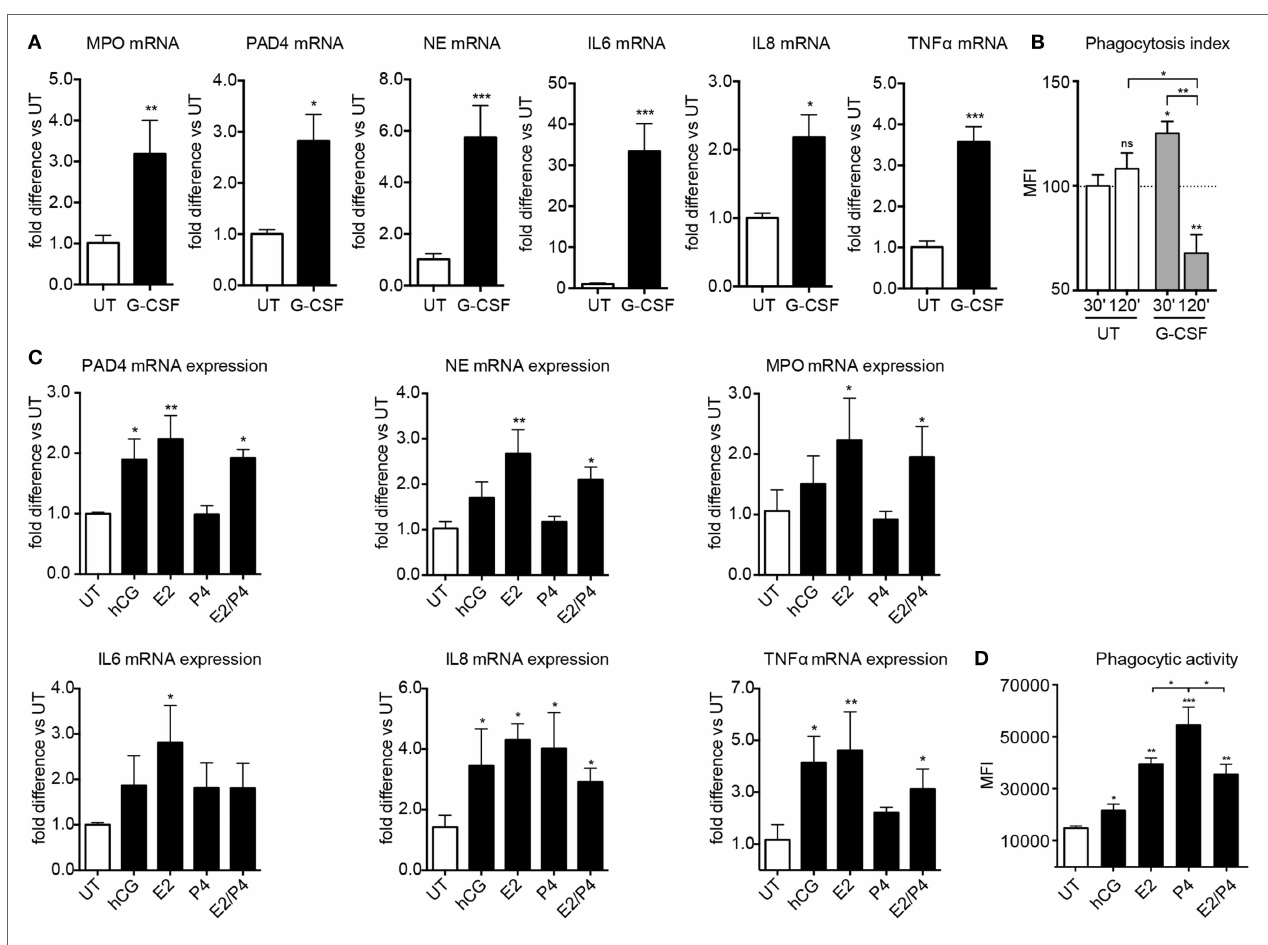
FigUre 5 | sex hormones and g-csF regulate broader aspects of neutrophil effector functions . (a) MPO, PAD4, NE, IL-6, IL-8, and TNF α gene expression analysis by Taqman qRT-PCR in RNA samples obtained from healthy female controls treated in vitro with 12.5 ng/ml rhG-CSF. (B) Phagocytic activity of neutrophils obtained from healthy female controls treated with 12.5 ng/ml rhG-CSF. (c) PAD4, NE, MPO, IL-6, IL-8, and TNF gene expression analysis by Taqman qRT-PCR in RNA samples obtained from healthy female control neutrophils treated in vitro with physiologic pregnancy concentrations of hCG (50 IU/ml), E2 (20 ng/ml), P4 (50 ng/ml), and the combination of E2 and P4 for 3 h. (D) Phagocytic activity in neutrophils from healthy control donors treated in vitro with physiologic pregnancy concentrations of hCG, E2, P4, and the combination of E2 and P4 for 3 h. Data are presented as mean ± SEM. * P < 0.05, ** P < 0.01, *** P < 0.001, and **** P < 0.0001 (one or two way ANOVA followed by Bonferroni’s multiple comparison post-test). All experiments were performed at least six times with consistent results. MFI, mean fluorescence intensity; UT,